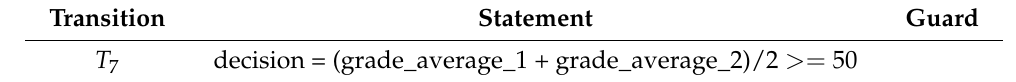
Table 3. Statements and guards of new transitions of the grading example.